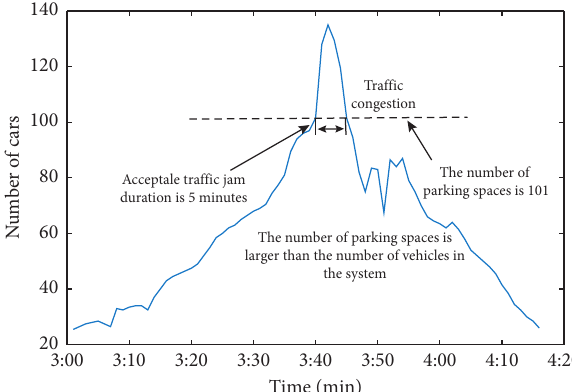
Figure 6: The number of vehicles during the pick-up.